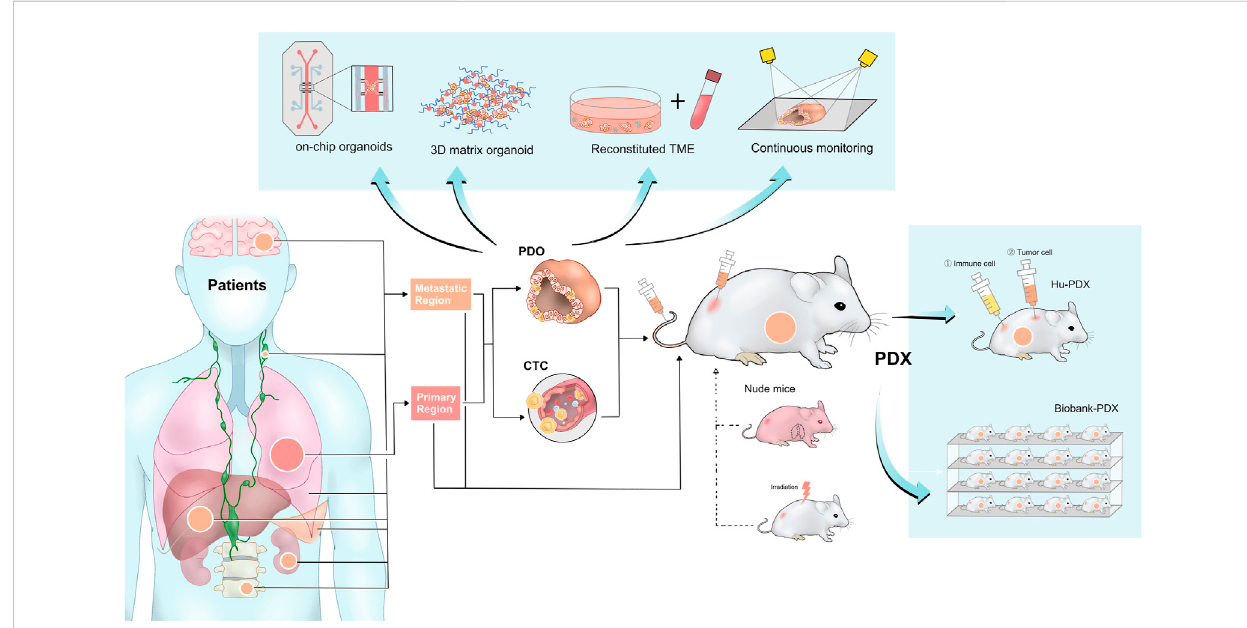
Different patient-derived lung cancer models and their cutting-edge technology foresight. PDX models can be established directly from primary tumors,metastaticlesions,pleural fl uid,andcerebrospinal fl uid.Meanwhile,patient-derivedlungcancerspecimenscanbeusedtoisolateCTCorculture organoid. PDX models can subsequently be established from treated organoid or CTC, indicating the different patient-derived lung cancer models are complementary and capable of mutual transformation. The blue-shaded boxes represent the Frontier area of research in patient-derived lung cancer models, including organoid culture technology, exploration of the possible mechanisms of immunotherapy in the Hu-PDX model, and highly promising biobank. PDX, patient-derived tumor xenograft; PDO, patient-derived organoid; CTC, circulating tumor cells; Hu-PDX, humanized PDX; TME, tumor